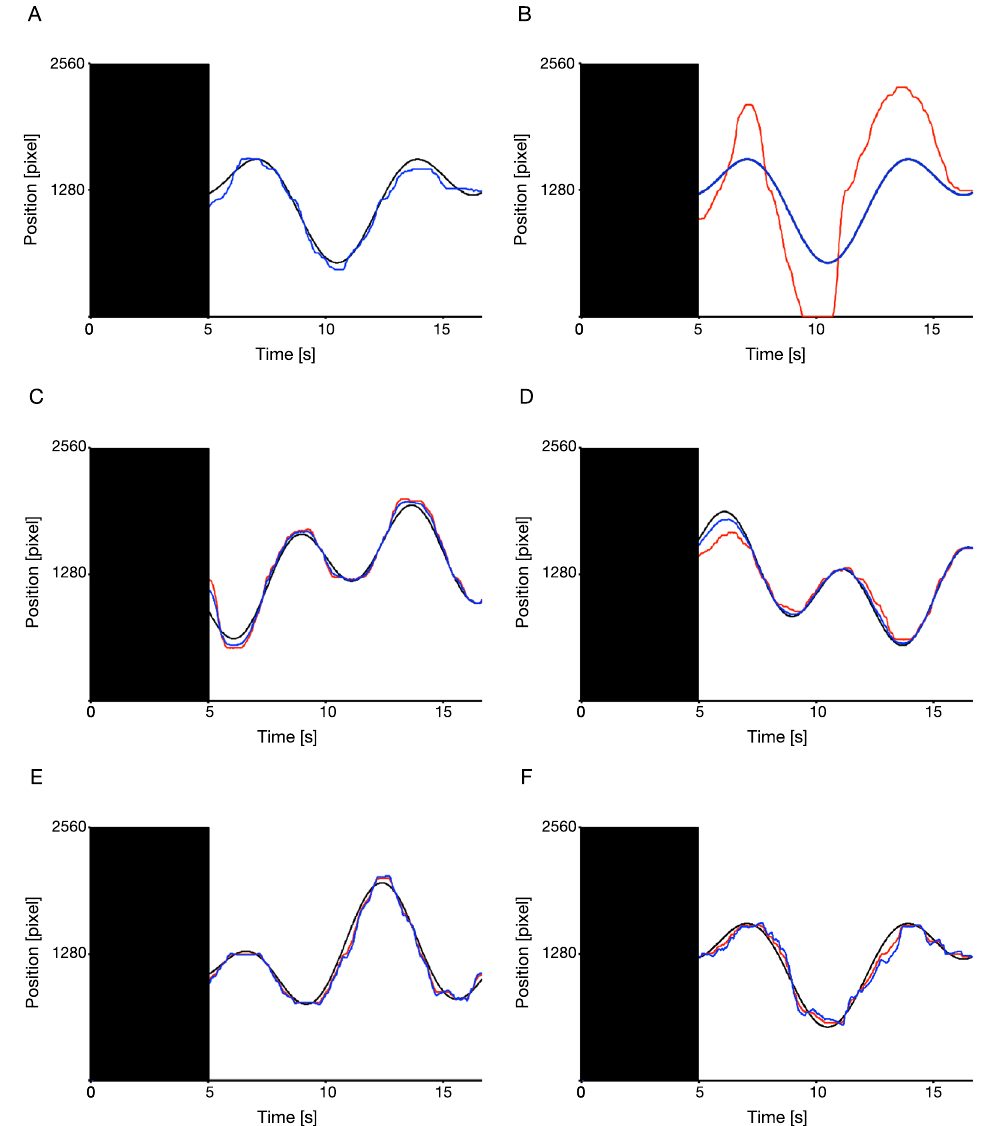
Figure 2. Examples of the movements of the target and the cursor in the complete control ( A ), full automation ( B ), 33% automation ( C ), 66% automation ( D ), − 33% automation ( E ), and − 66% automation conditions ( F ). Zero (2560) along the vertical axis indicates the left (right) side of the display. The black areas represent the preparatory epoch, where the cursor was invisible. The black curved lines represent the center of the target trajectories, and the colored lines represent the typical cursor movements of a participant (blue lines: the apparent cursor movements, red lines: the actual cursor movements). It is noted that participants could not see the actual cursor movement in this